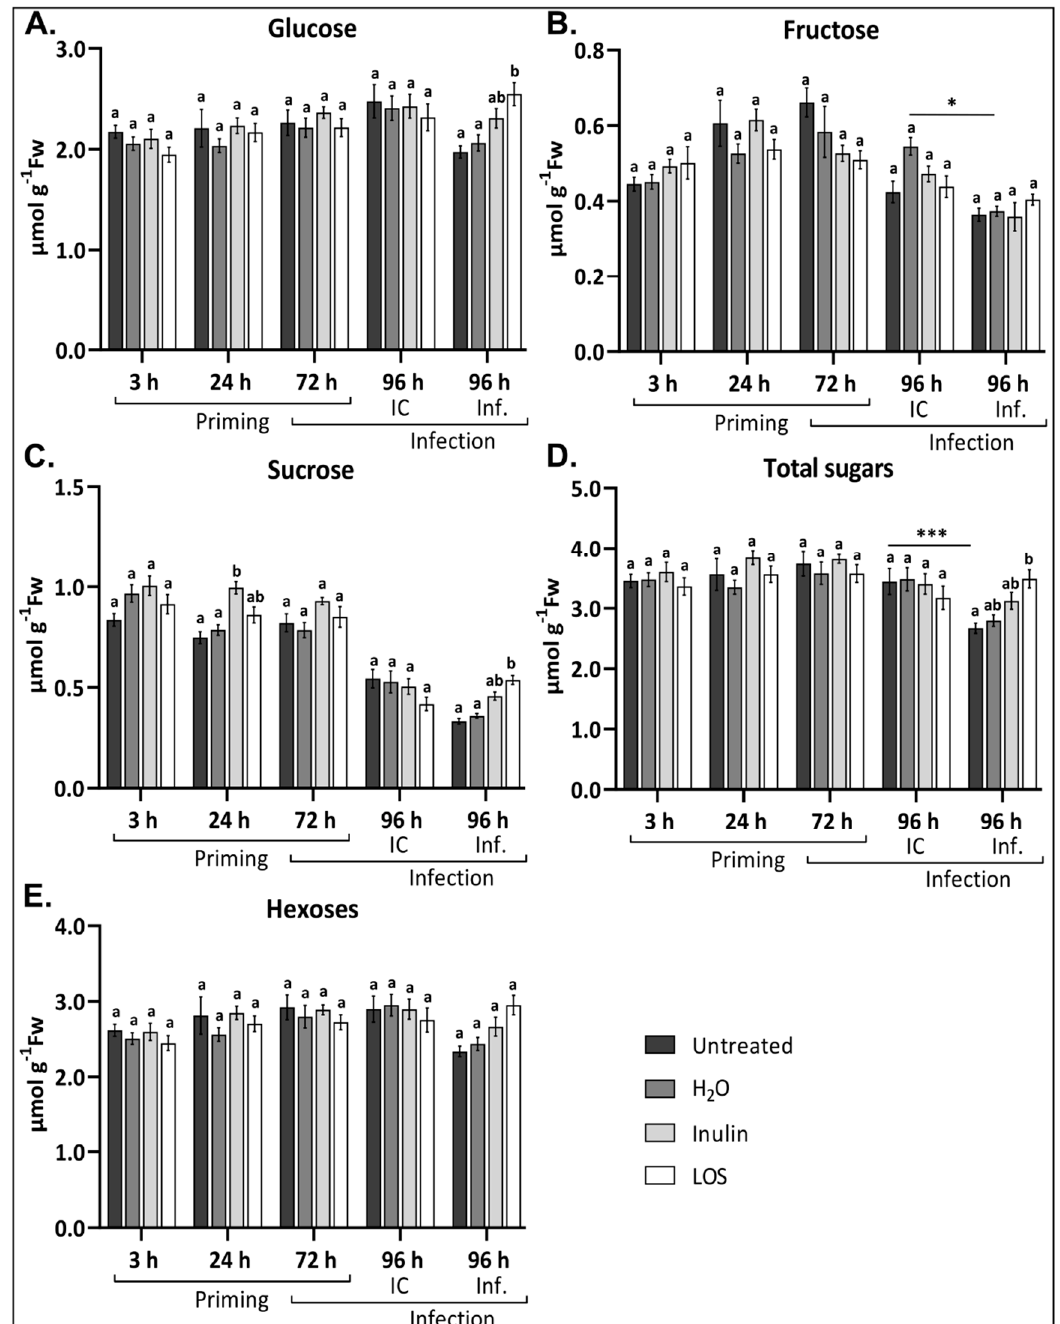
Figure 7. Soluble sugar analysis of the plants (comparable source leaves used in infections) treated with inulin and LOS in response to treatment and B. cinerea infection. Quantification of ( A ) Glucose (Glc) ( B ) Fructose (Fru), ( C ) Sucrose (Suc), ( D ) total sugars (Glc + Fru + Suc) and ( E ) hexoses (Glc + Fru) in untreated, H 2 O-treated, inulin-treated and LOS-treated plants (3 h, 24 h and 72 h) followed by infection for 24 h (96 h). Infection control (IC) plants contained infection buffer without spores. Bars represent the mean ± SE ( n = 6, biological repeats). Statistical significance is indicated by different letters (a,b) within the same time point ( p < 0.05) and with an asterisk (* p < 0.05, *** p < 0.001) between time points, and is based on two-way ANOVA followed by Tukey’s multiple comparison test and adjusted p values. Experiments were repeated three times with consistent results.